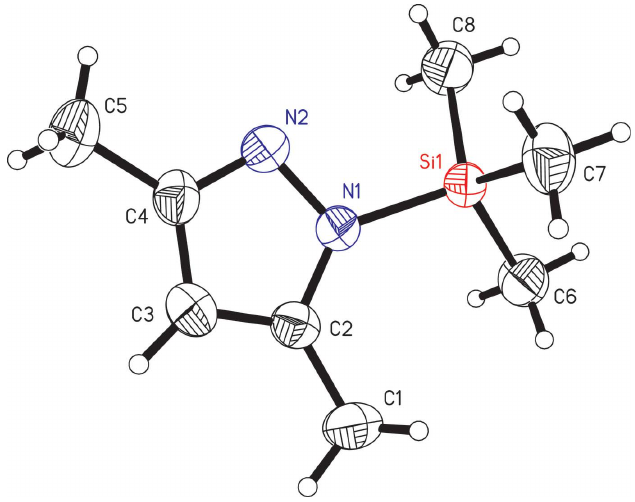
Figure 2 Hydrogen bonds between N2 and H6 B of neighboring molecules along a twofold screw axis (2 1 ) parallel to the crystallographic b axis.